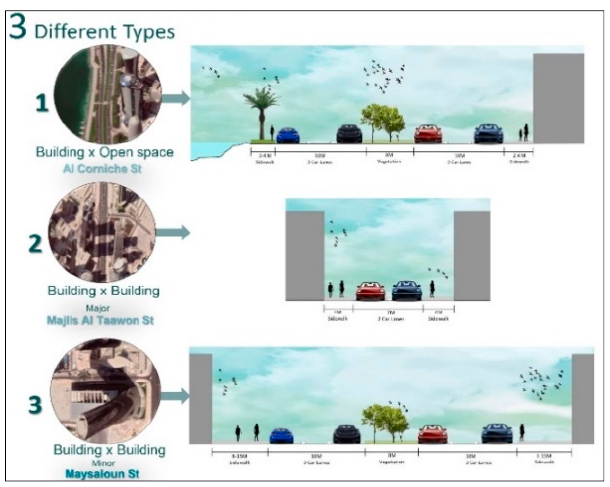
Figure 18. Various street prototypes in cross section (Source: the Authors).